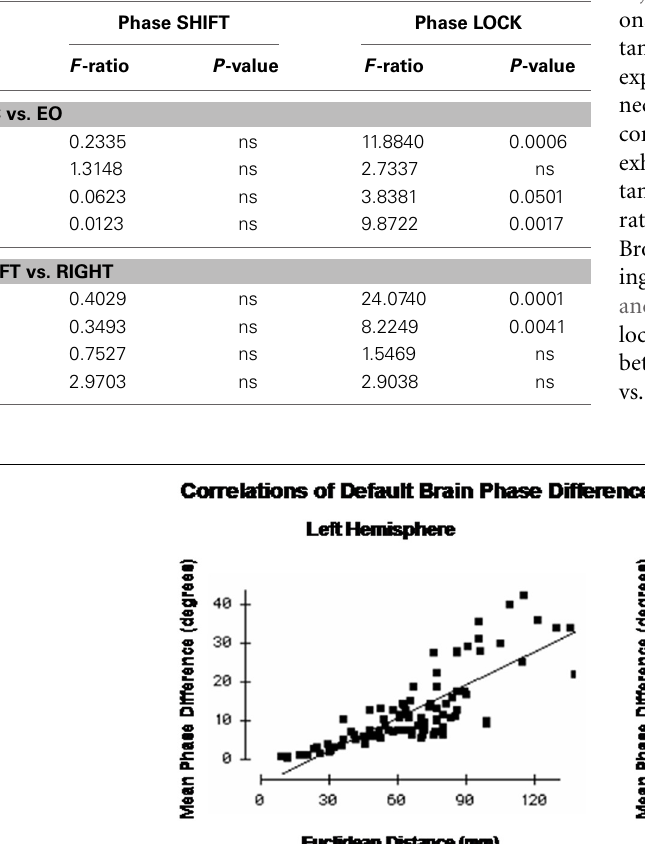
Table 4 | The results of the MANOVA for eyes closed vs. eyes open conditions and hemisphere for phase lock and phase shift durations.